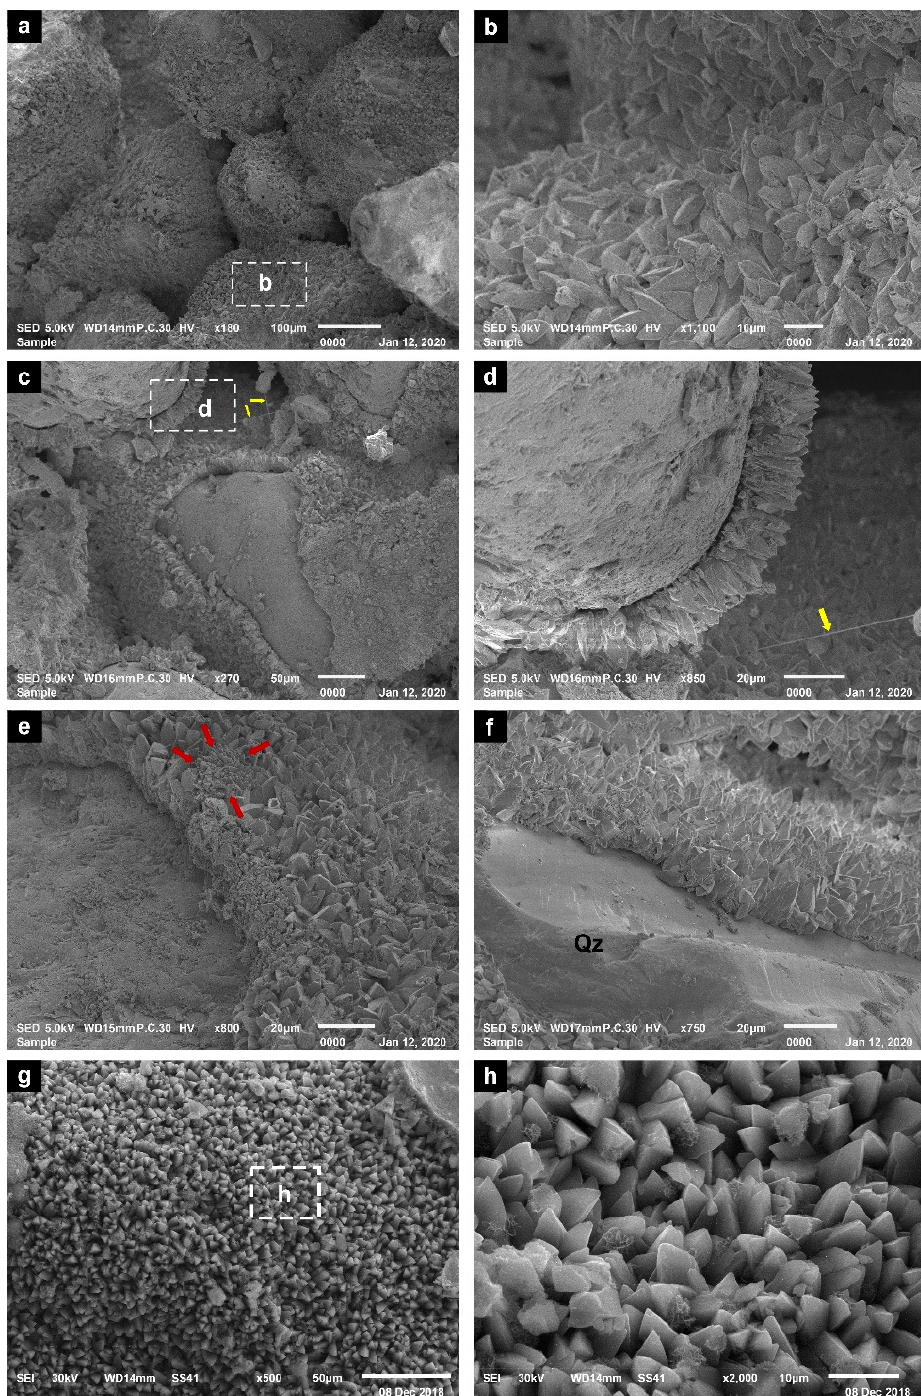
Figure 5. SEM photo micrographs showing the characteristic features of the carbonate cement in the Wadi Al-Hamd beachrocks. ( a , b ) HMC blades surrounding grains and the crystals show random orientation (sample HMD 1). ( c – e ) Isopachous HMC calcite blades grow perpendicular to the grain surface (sample HMD 5). The length of the blades is up to 18.3 µm; note the organic filaments (yellow arrows) that support the contribution of algal activity in cement formation. Small radial aggregate encrusting the bladed cement is shown by red arrows. ( f – h ) Pore-filling HMC calcite cements taking a well-developed bladed shape (sample HMD 7) surrounding quartz